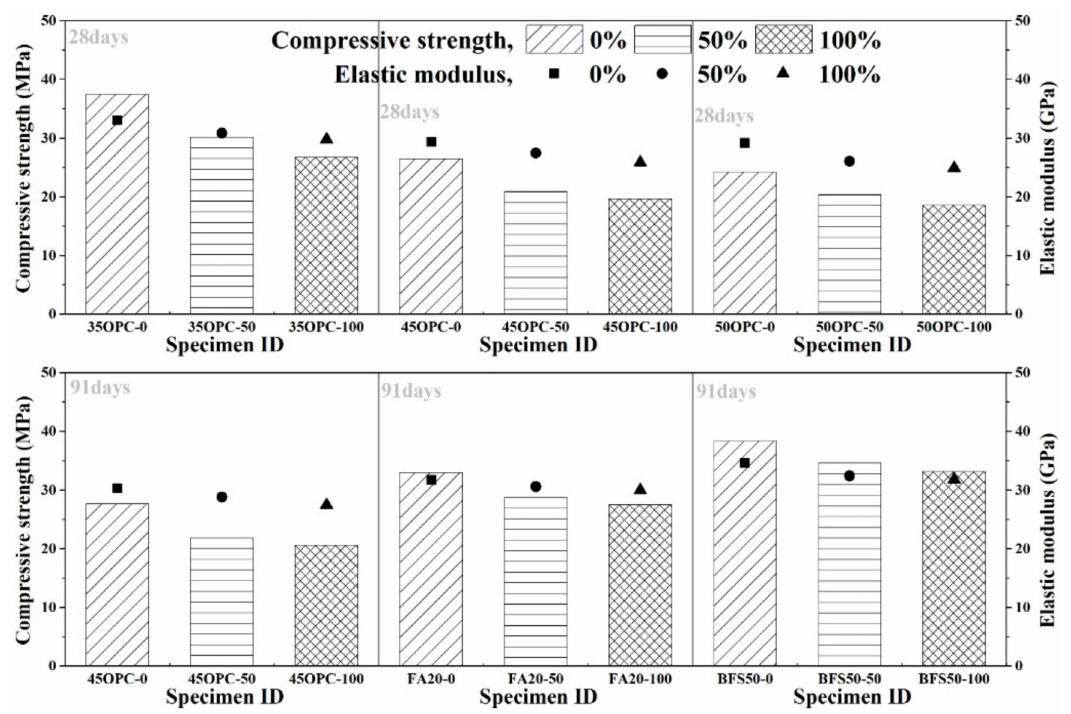
Figure 3. Compression properties of concrete specimen.